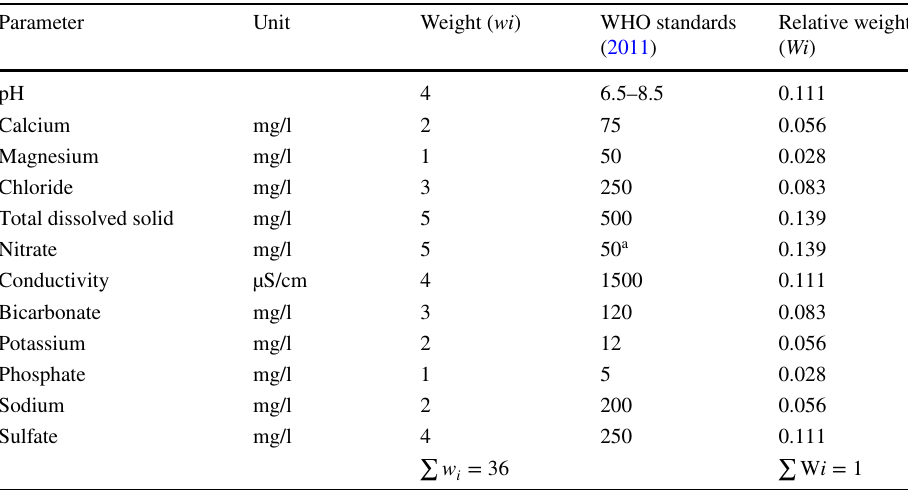
Table 2 Weight and relative weight of each parameter used for the WQI calculation